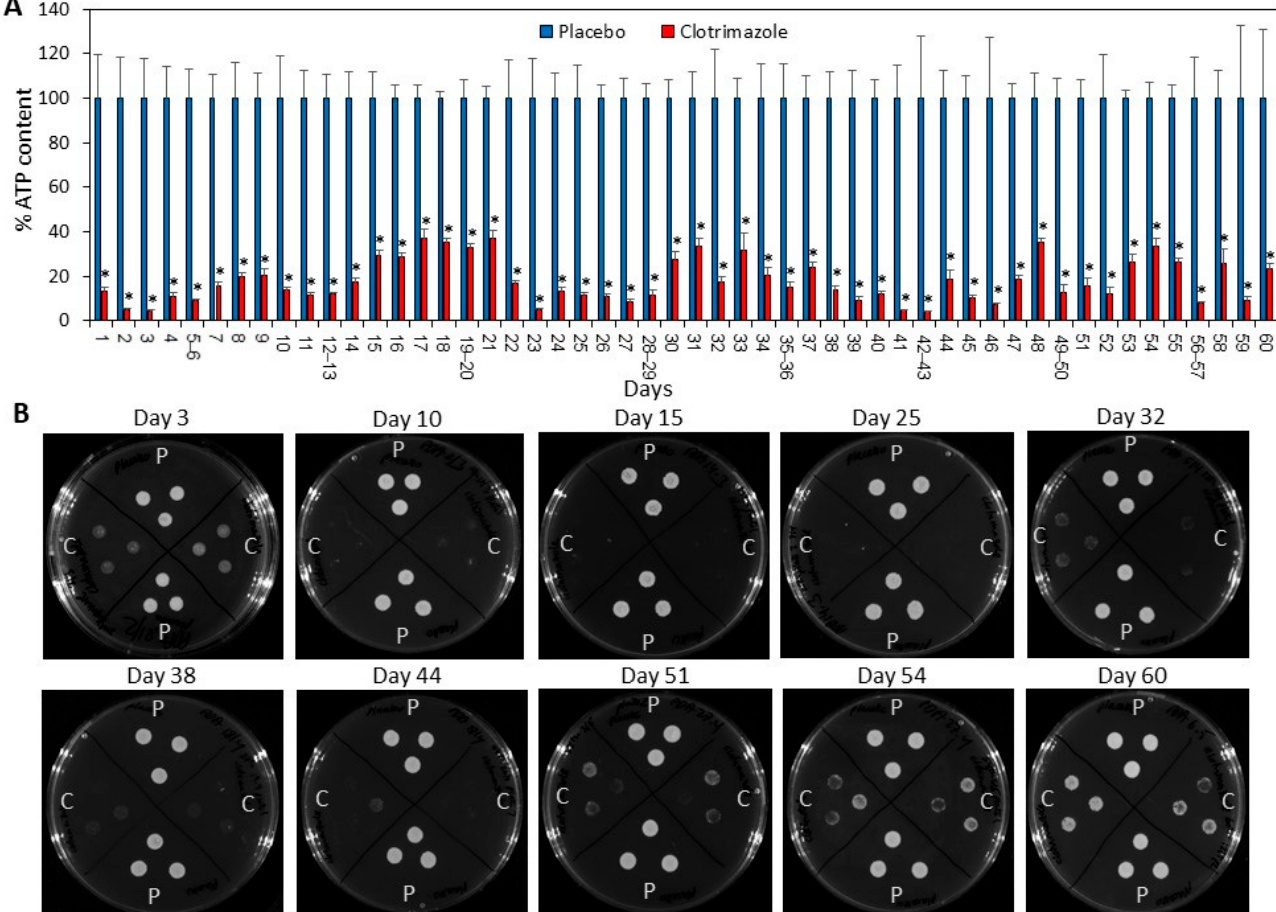
Figure 3. SRV-CTZ-coated VPs prevented the planktonic growth of C. albicans . ( A ) SRV-CTZ- and placebo-coated VPs were daily incubated with fresh C. albicans cultures, and the relative ATP content of the fungi after a 24 h incubation was determined. * p < 0.05 versus placebo. ( B ) 3 drops of 10 µ L from each sample from experiment described in A, were seeded on agar plates to analyze the ability of the fungi to grow after being exposed to SRV-CTZ- or placebo-coated VPs. C = Samples exposed to SRV-CTZ-coated VPs. P = samples exposed to SRV-placebo-coated VPs. N = 3–5.